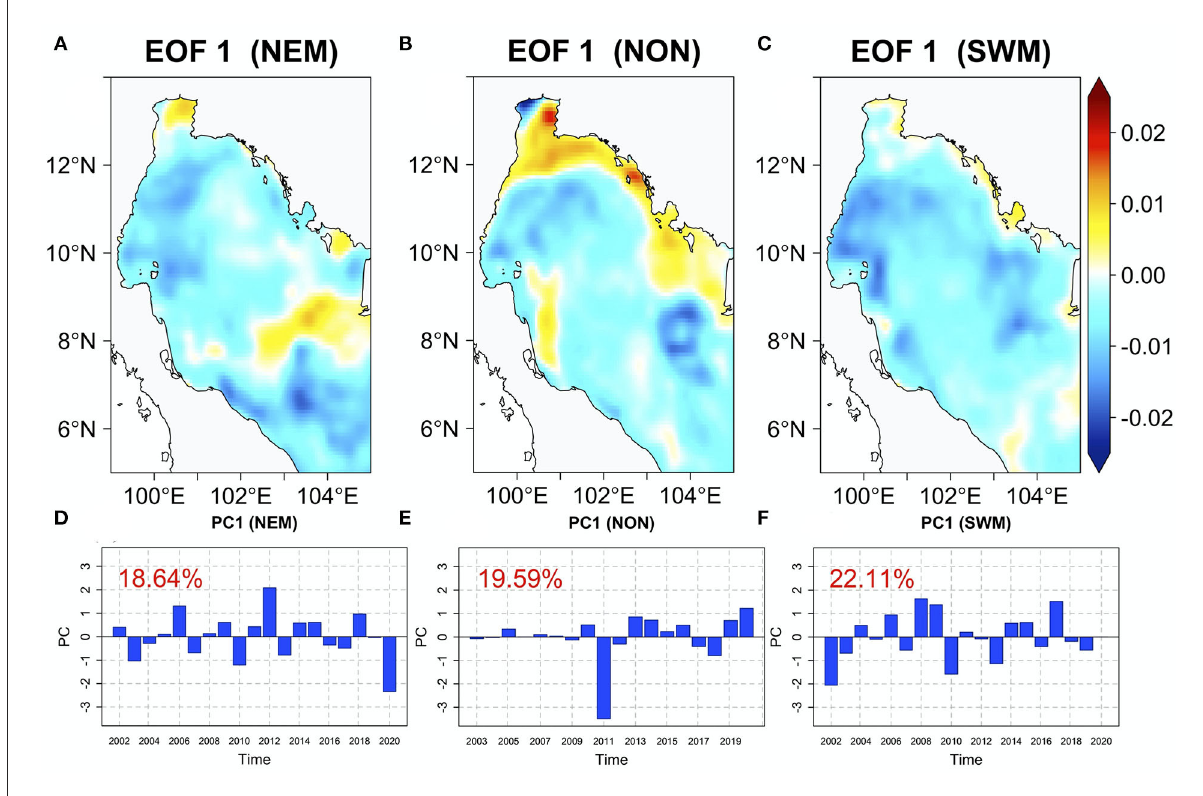
spatial gaps were reconstructed using the DINEOF